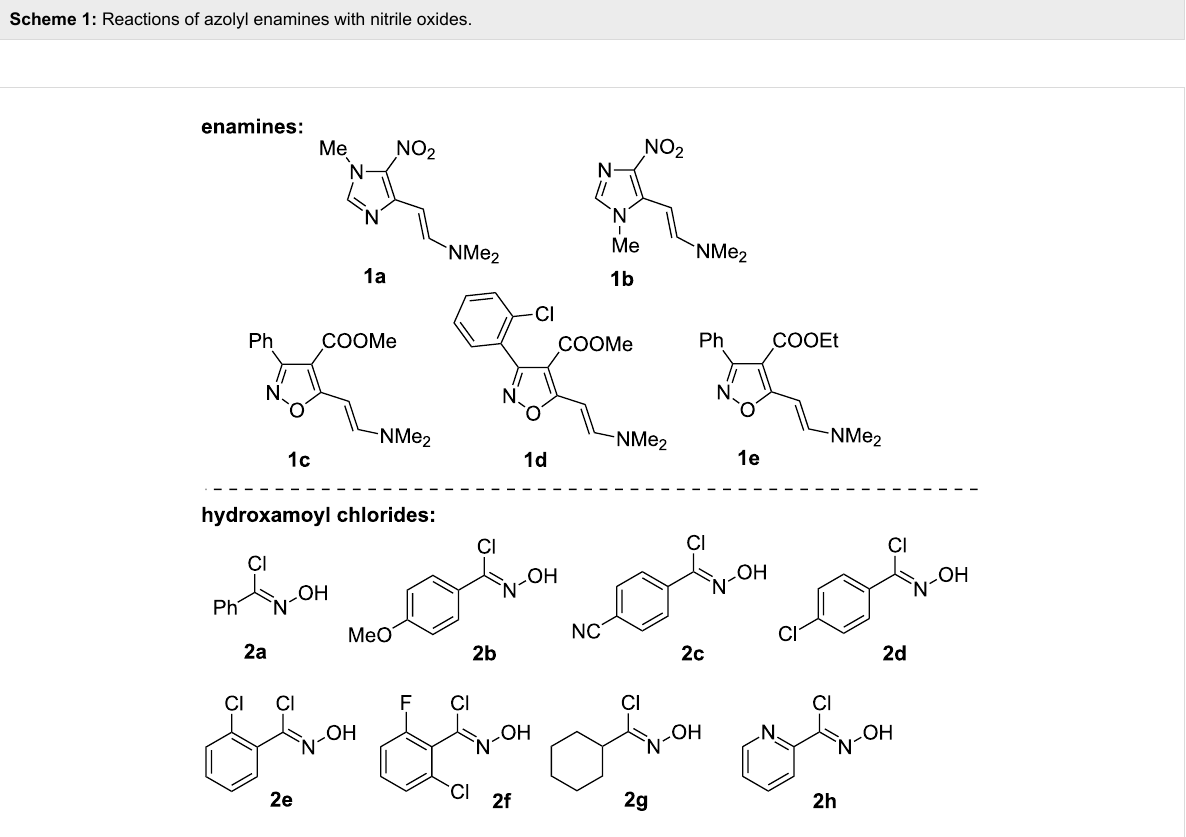
Figure 2: Structures of starting enamines 1 and hydroxamoyl chlorides 2